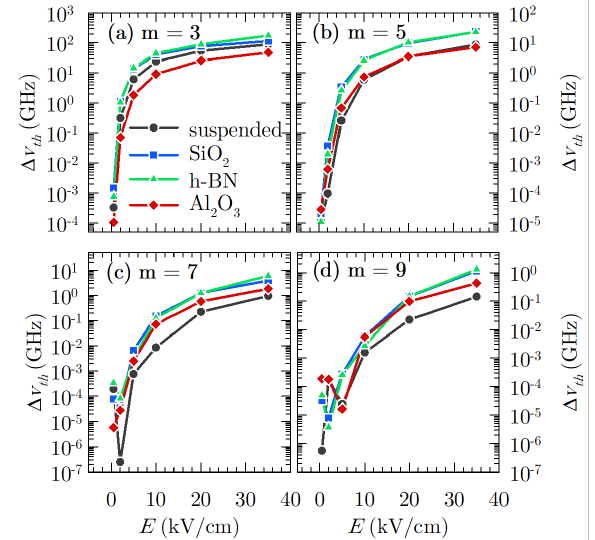
Figure 8. Threshold bandwidth for the ( a ) third, ( b ) fifth, ( c ) seventh, and ( d ) ninth harmonics of the excitation frequency f = 300 GHz in the four cases under study as a function of the electric field and a temperature of 300